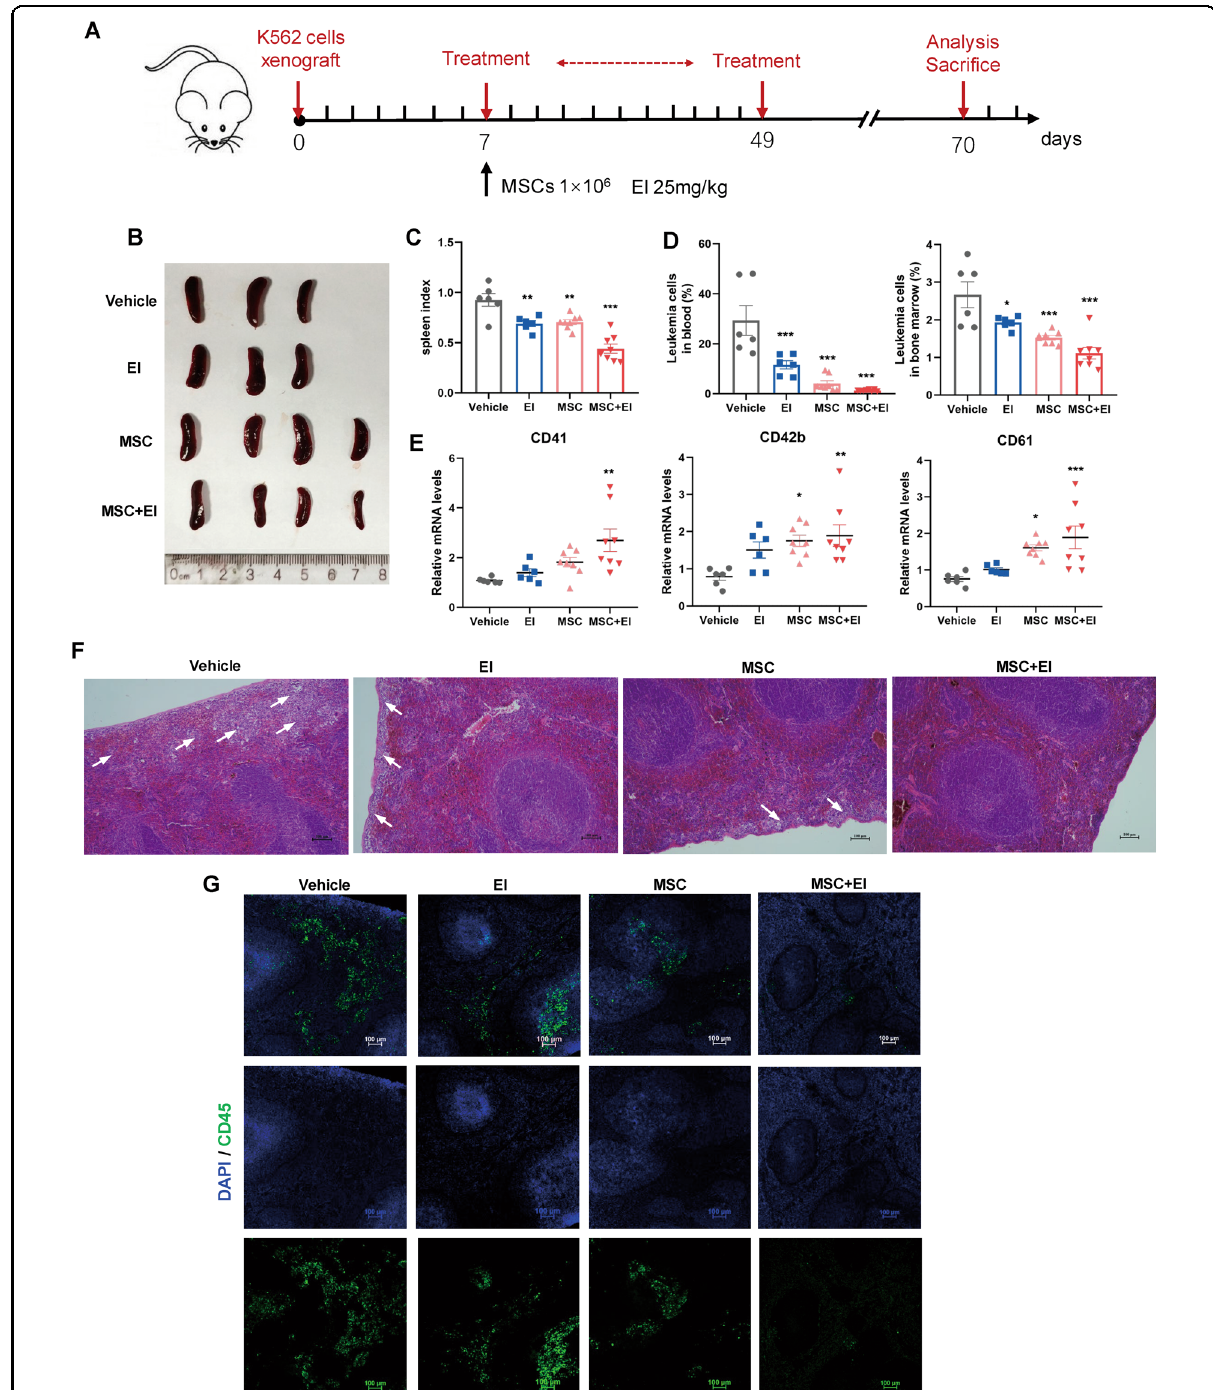
Fig. 5 El potentiated the ef fi cacy of MSCs on anti-leukemia in vivo. A Schematic illustration of experimental design. B Representative images of spleens from four groups. C The weight of spleens in different groups. D Percentage of human CD45 + leukemia cells in peripheral blood (PB) and bone marrow (BM) in vehicle and treatment mice after 10 weeks of transplantation. E Human CD45 + cells from a single-cell suspension of peripheral blood were sorted using FASC. RT-qPCR analysis on FACS-isolated human CD45 + cells for CD41, CD42b, CD61. F Histologic sections of spleen were stained with hematoxylin-eosin. Scale bars, 100 μ m. G Representative in fi ltration of CML cells in the spleen as observed via immuno fl uorescence with anti-CD45 antibody (green). Nuclei are stained with DAPI (blue). Scale bars, 100 μ m. All statistical data in this fi gure showed the mean ± SEM (* P <0.05, ** P <0.01, *** P <0.001; one-way ANOVA was used for multiple comparisons). El